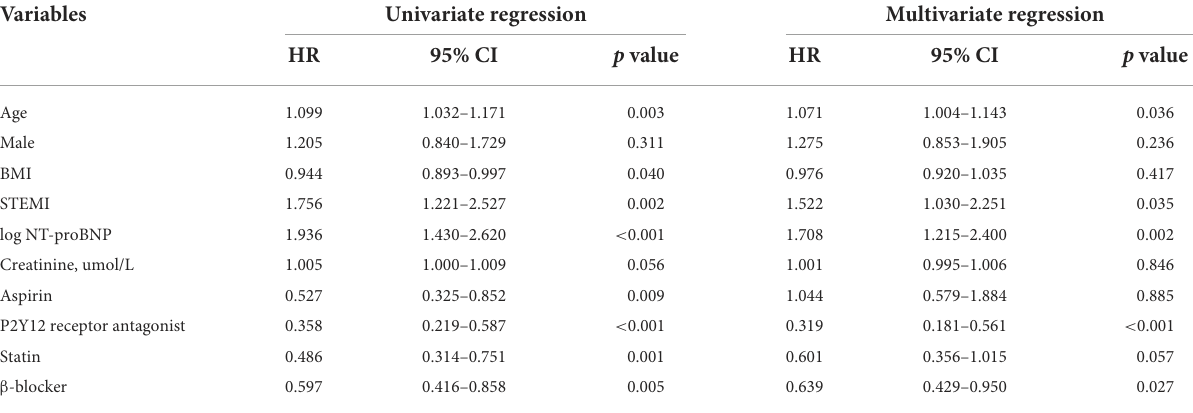
TABLE 4 Cox proportional hazards regression analyses for composite MACCE in PCI group.